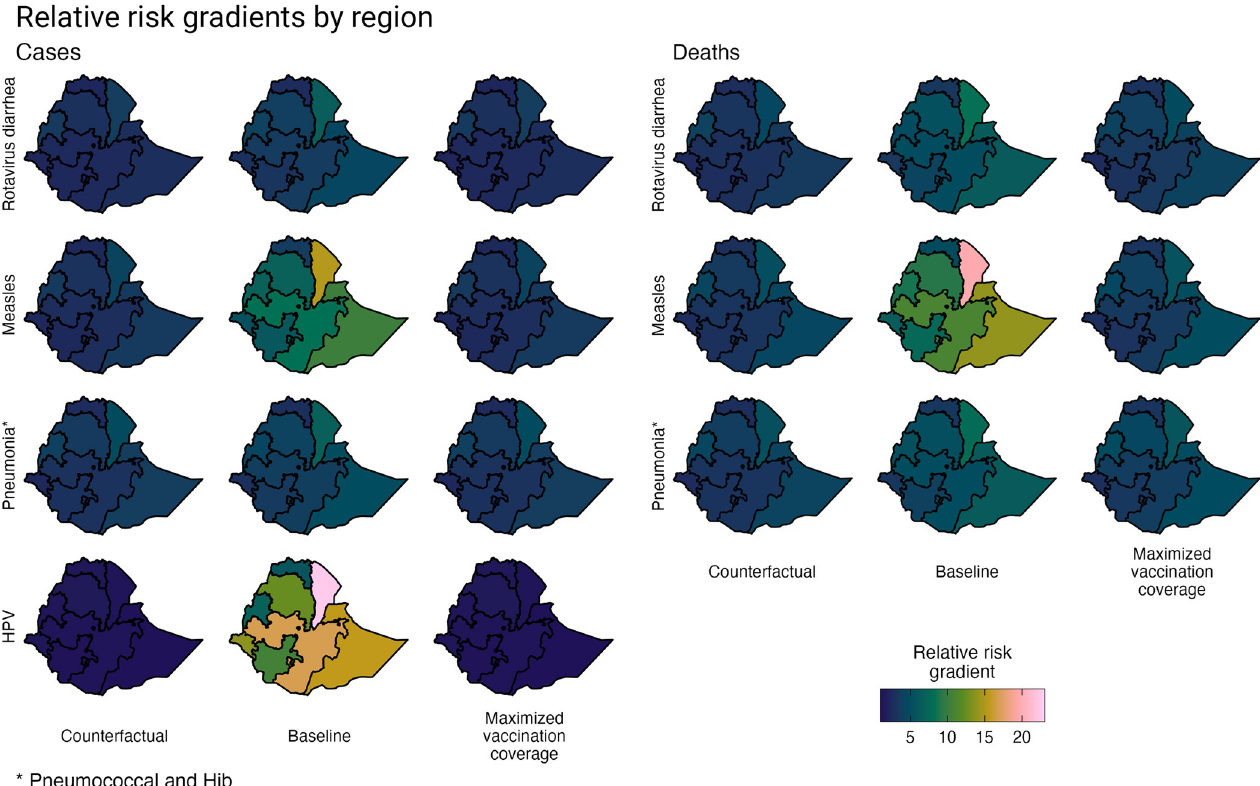
Fig 3. Relative risk gradients of rotavirus diarrhea, measles, pneumonia (pneumococcal and Hib), and HPV incidence and mortality across three scenarios by geographic region. The three scenarios include the distribution of risk and prognostic factors. The “counterfactual” scenario presents a scenario without vaccination or treatment-seeking behavior; the baseline scenario presents a scenario with current vaccination coverage and treatment-seeking behavior, and the maximized vaccination coverage scenario presents a scenario in which vaccination coverage in all population subgroups is increased to the level of vaccination coverage of the subgroup with the greatest vaccination coverage (e.g., all quintiles are modeled as having the same level of vaccination coverage as the richest quintile). Base map data is available from GADM: